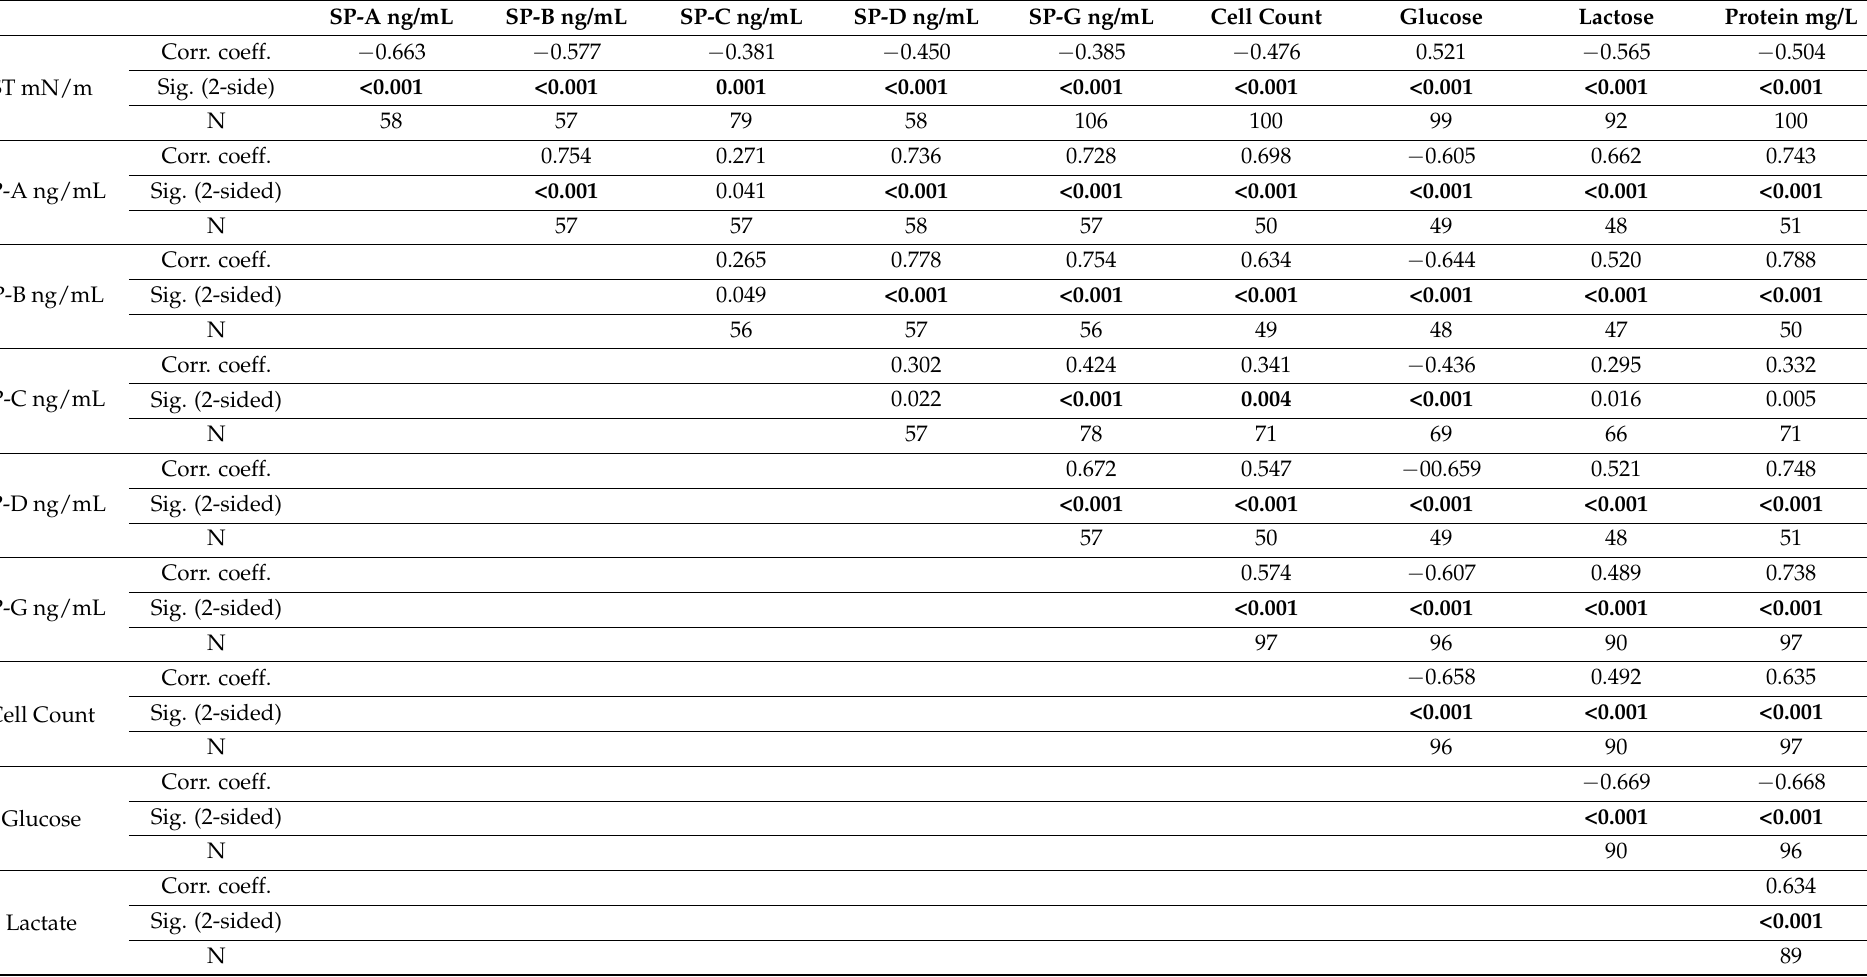
Table 2. Spearman rho test: correlation of clinical factors and